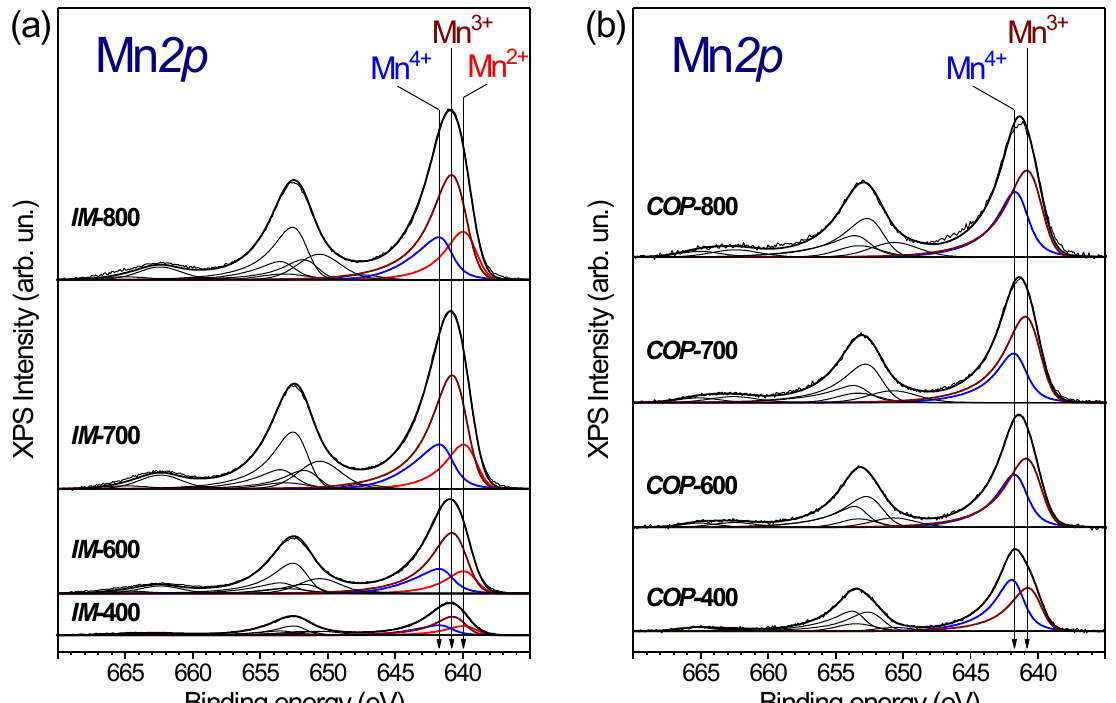
Figure 7. Mn 2p core-level spectra of the IM ( a ) and COP ( b ) catalysts. Mn 2p spectra are normalized to the integral intensity of the corresponding Zr 3d spectra.